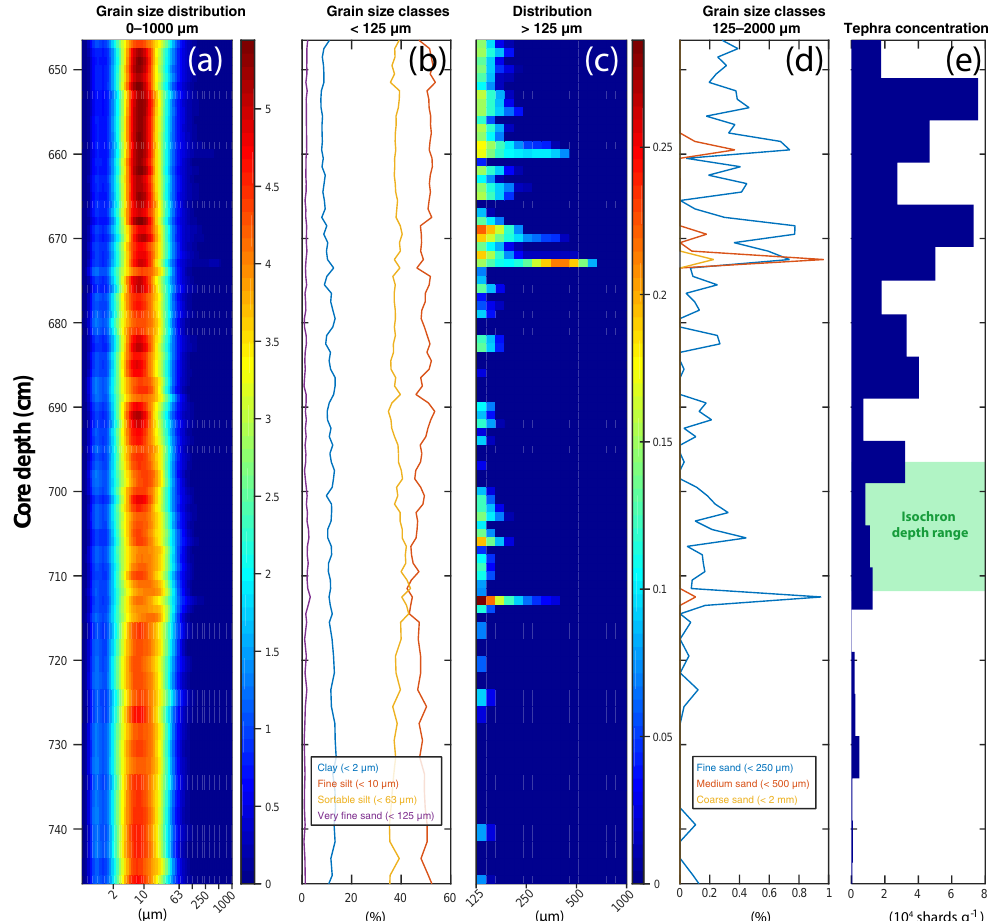
Figure 4. Grain size distribution (a–d) and tephra concentrations (e) between 640 and 750cm depth in Core 2PC. (a) Full grain size range (0–1mm) plotted as distribution percentages in a surface plot. (b) Grains < 125µm in categories. (c, d) Grain size distribution for grains > 125µm as surface (c) and categories (d) . Note the different color scale values for the percentages between (a) and (c)